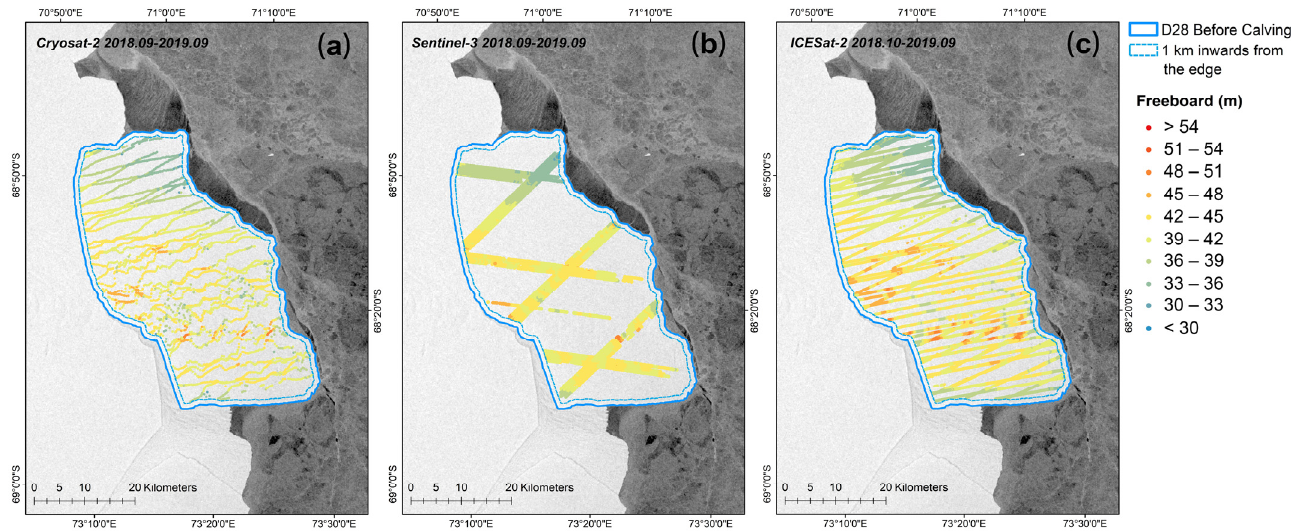
Figure 2. Altimetry data used to estimate the draft of iceberg D28. ( a ) Cryosat-2, ( b ) Sentinel-3, and ( c ) ICESat-2 data distributions over the front part of Amery Ice Shelf with a base image from Sentinel-1 on 20 September